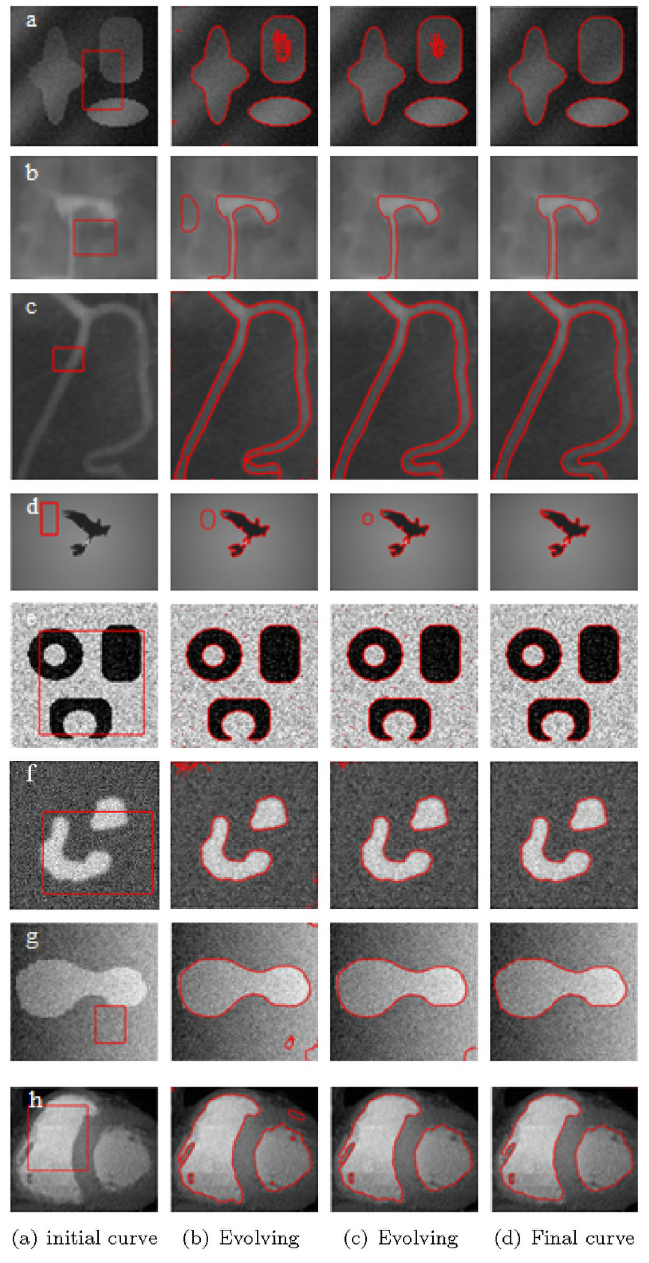
Fig 5. Segmentation results of partial images. column 1: initial contour. column 2 to 3: intermediate segmentation results. column 4: final segmentation results. In Fig 5, the first row shows composite images, with heavy shadows. The second row shows salpingography images, with low contrast. The third row shows real images of blood vessels, with inhomogeneous intensities. The fourth row shows images of birds with uneven gray scales. The fifth and sixth rows are composite images with noises. The seventh row displays the composite noisy image with uneven illumination. The images in the last row are of a real heart. These images are characterized by low contrast, high noise and blurred edges. It is clear